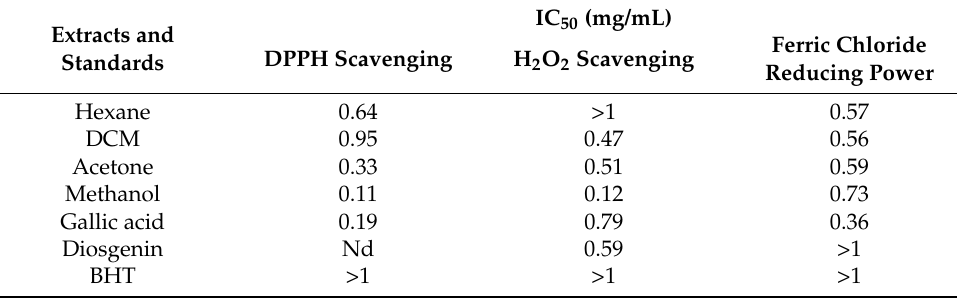
Figure 4. Hydrogen peroxide percentage inhibition of Mistletoe extracts and standards. Each value is expressed as mean ± standard deviation ( n = 3). Table 4. IC 50 values indicating the potential inhibition by the four Mistletoe